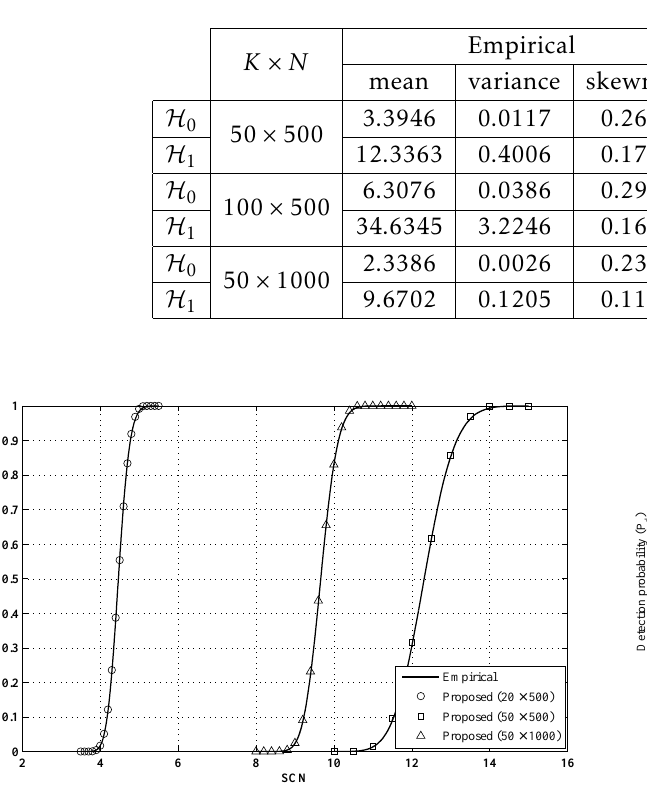
Figure 2. Empirical CDF of the SCN and its corresponding proposed GEV approximation for different values of K and N under H hypothesis with ρ = − 10 dB . 1